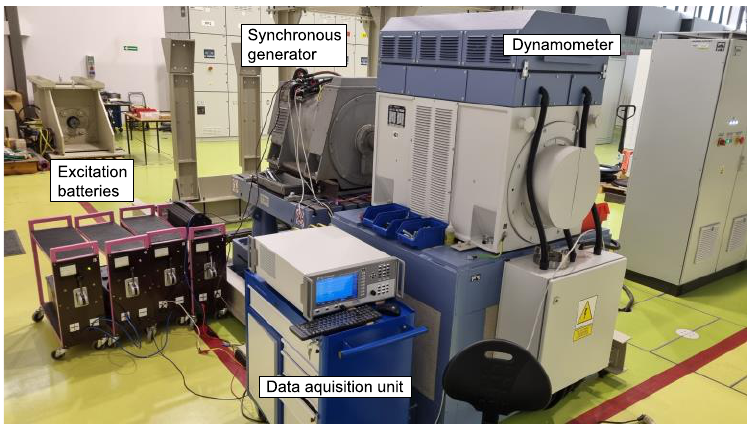
Figure 4. Measurement setup with the dynamometer and the studied synchronous